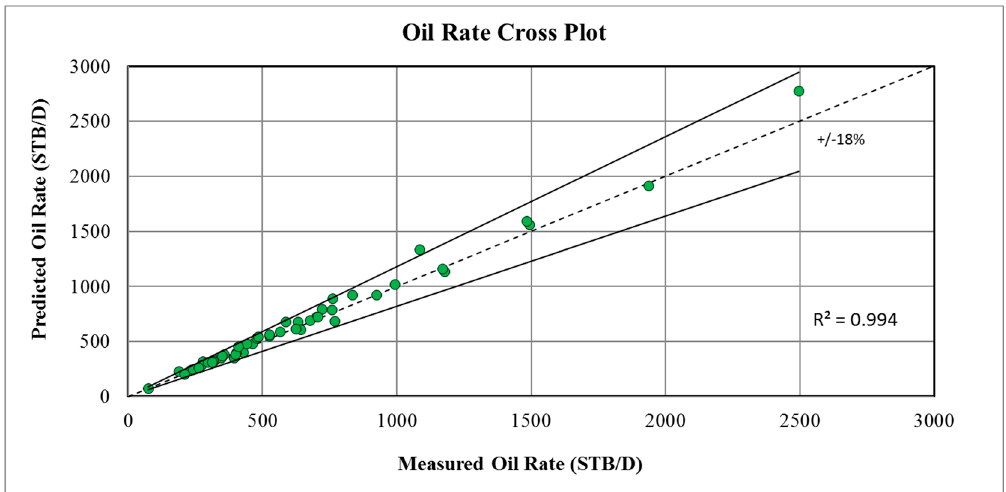
Figure 8. Predicted vs measured oil rate using the Blasius correlation. Energies 2018 , 11 , x FOR PEER REVIEW